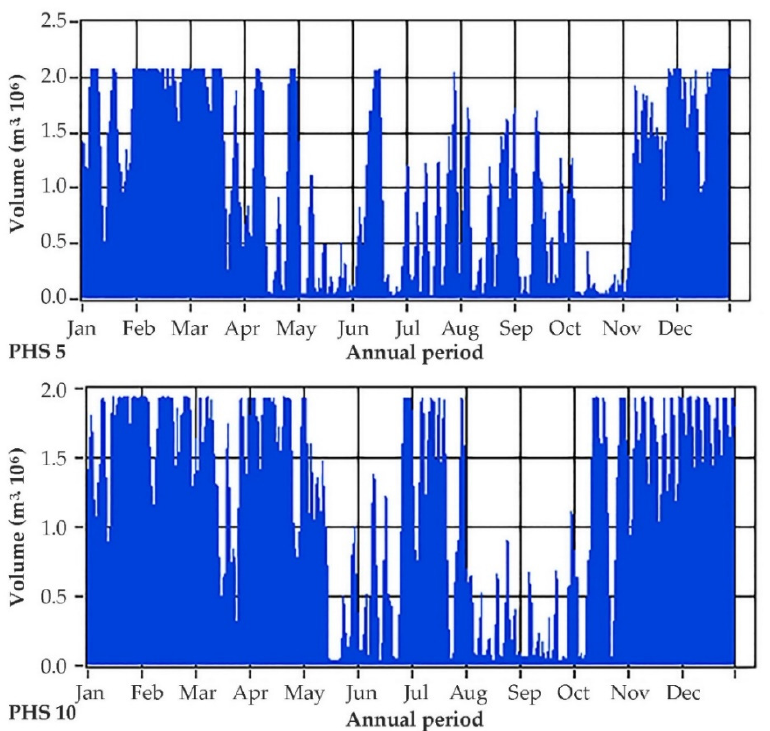
Figure 26. Annual fluctuation in the water stored volume in the PHS systems’ 5 and 10 upper reservoirs.